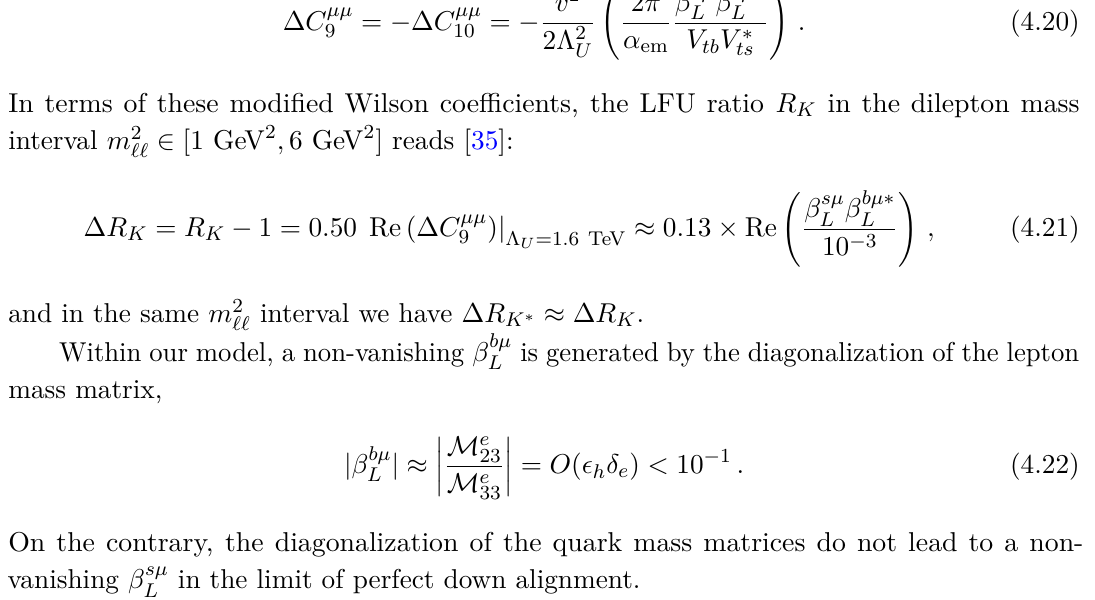
Figure 7 . Box diagrams leading to an effective a (heavy) SU(3) l -singlet